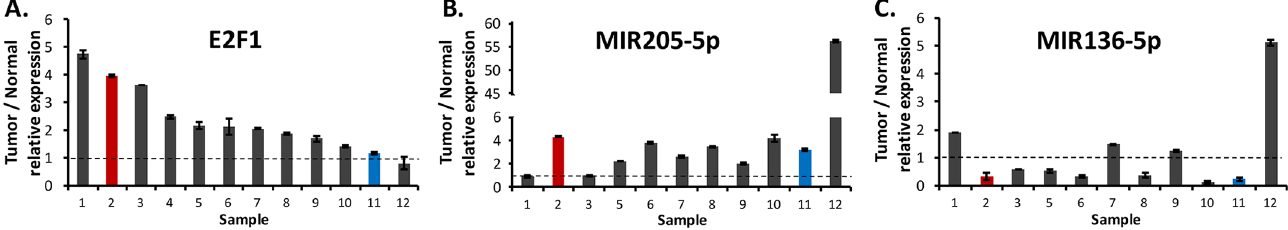
Fig 2. E2F1 and miRNA expression in a set of patient samples. A) E2F1 expressionin tumor relative to normaltissue was evaluatedby qPCR; PUM1 and HMBS expressionwere used for normalization. B) MIR205-5p and C) MIR136-5ptumor expressionrelative to normalexpressionwas evaluatedby qPCR; RNU6b expressionwas used for normalization. Red: patient #2 carries a somatic mutation at E2F1 :MIR136-5ptarget site. Blue: patient #11 carries a germline alterationat E2F1 :MIR205-5ptarget site. Dashedline represents the same expressionvalue betweennormal and tumor tissues. Error bars indicate the SEM of experiments in